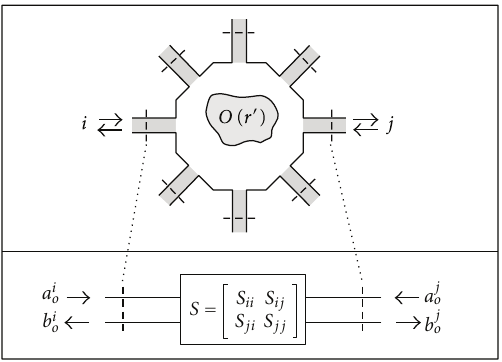
Figure 1: Microwave network model of cavity and scattering object. S -parameters are measured between the reference planes on the transmission lines.